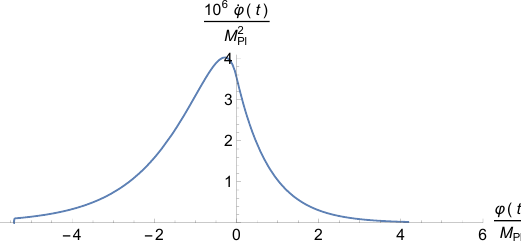
Figure 1. Evolution of the velocity of the scalar field, as a function of scalar field, obtained integrating the equation conservation ¨ ϕ + 3 H ˙ ϕ + V ϕ = 0, with initial conditions when the pivot scale leaves the Hubble horizon, i.e., for ϕ ∗ = − 5.42 M pl and ˙ ϕ ∗ =